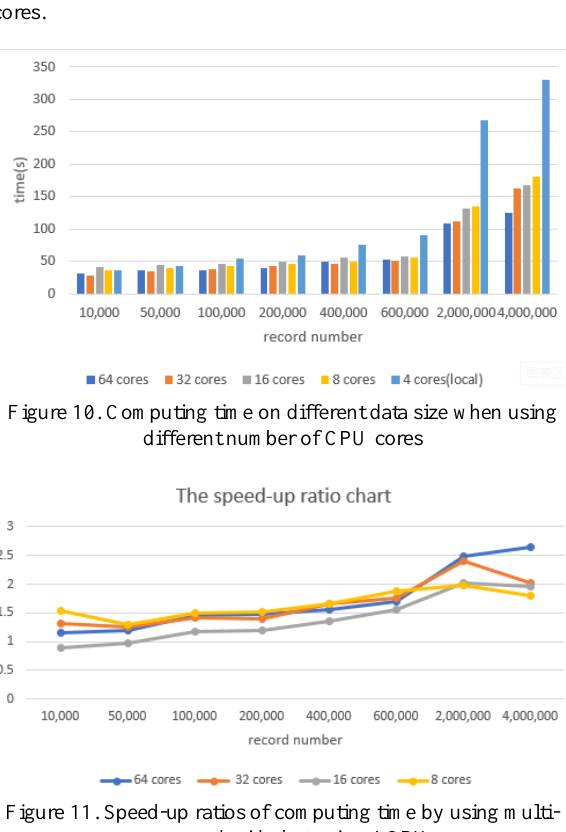
Figure 8. The shifting route of gravity centers of wholesale,